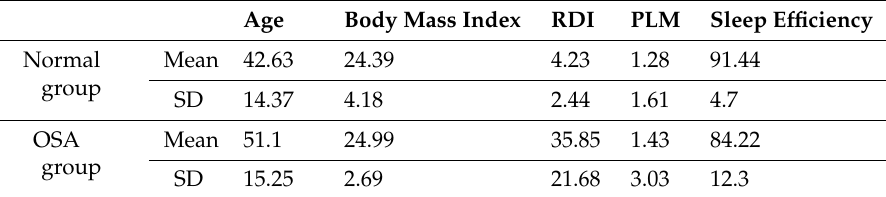
Table 2. Statistics of the two groups in the sleep-wake detection experiment. SD means standard deviation. RDI (respiratory disturbance index) is the number of abnormal breathing events per hour of sleep. PLM (periodic leg movements) is the number during nocturnal sleep and wakefulness. Sleep efficiency is the proportion of sleep in the episode, i.e., the ratio of total sleep time (TST) to the time in